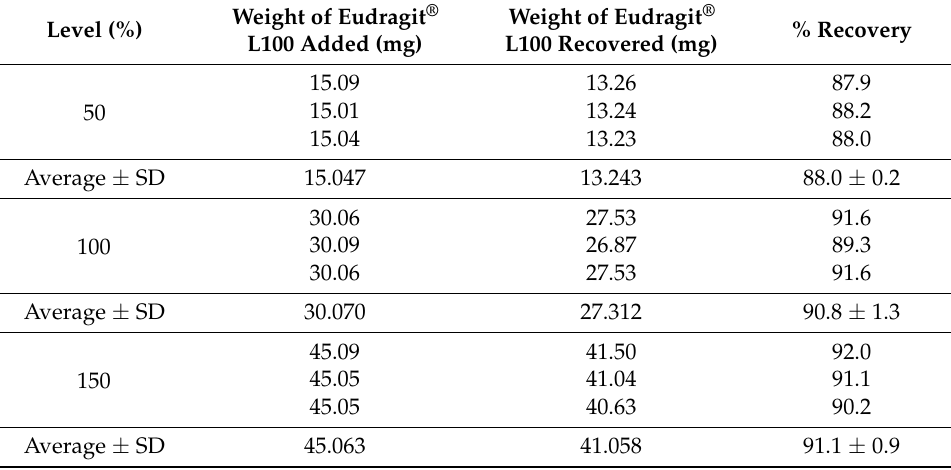
Table 2. Recovery of Eudragit ® L100 in placebo of coating layer of tablet.